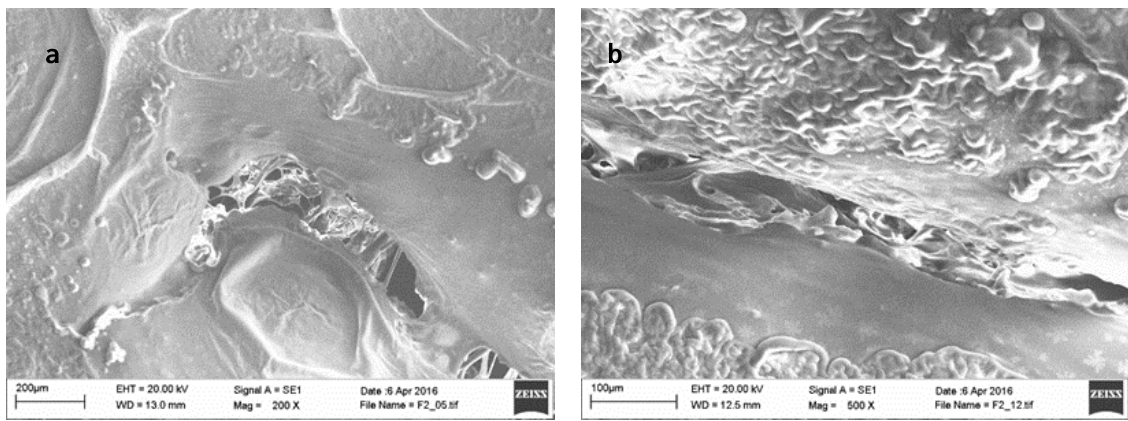
Figure 3. ’Florina’ peel segments at 200x (a) and 500x (b) magnifications after